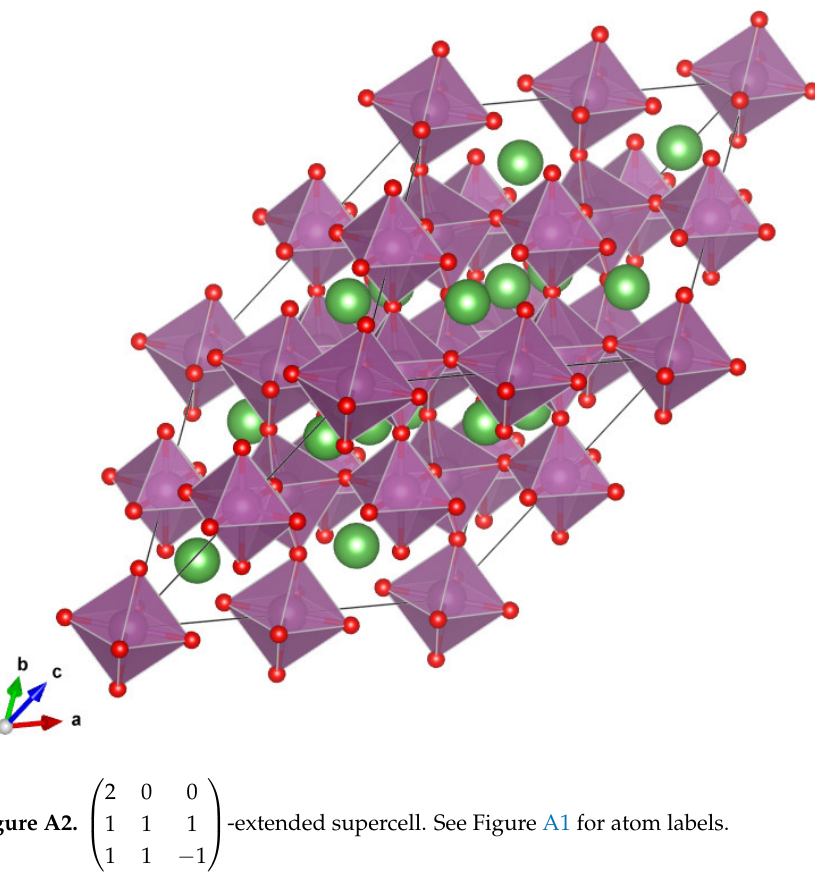
Figure A2.   -extended supercell. See Figure A1 for atom